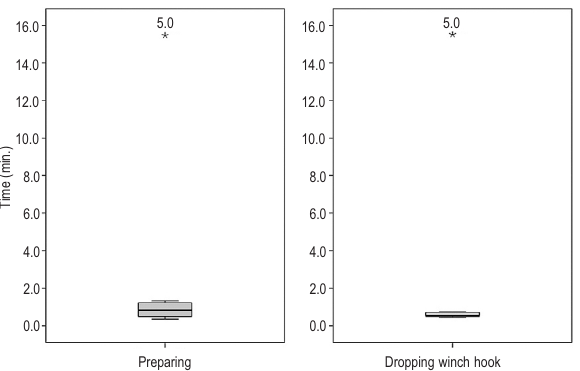
4.Fig. 6. Boxplot of the measured duration data for the activities of “ Preparing ” and “ Dropping winch hook ” in the installing process